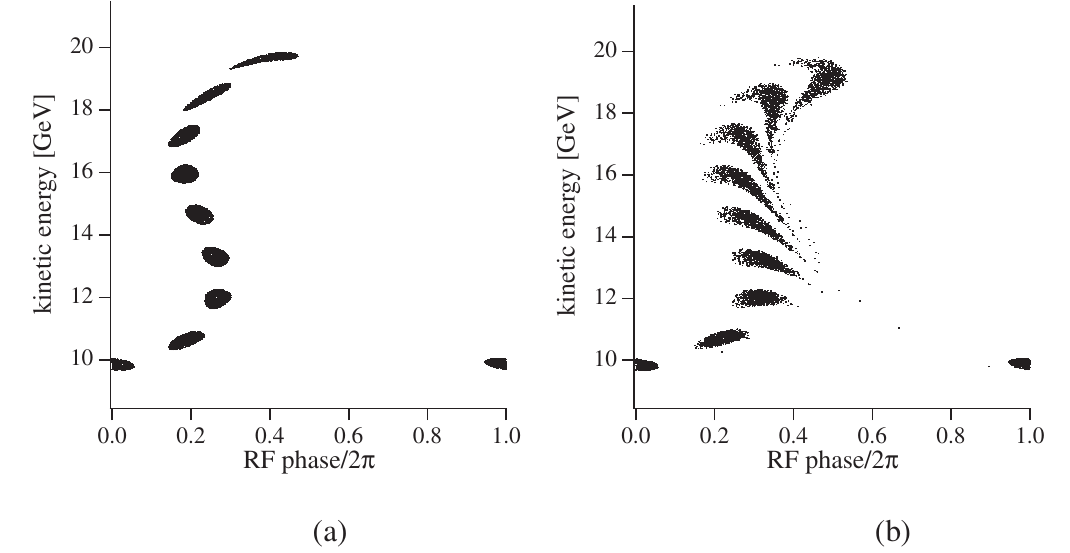
FIG. 3. Longitudinal emittance evolution (a) without and (b) with 100% transverse emittance of 30 (cid:1) mm rad